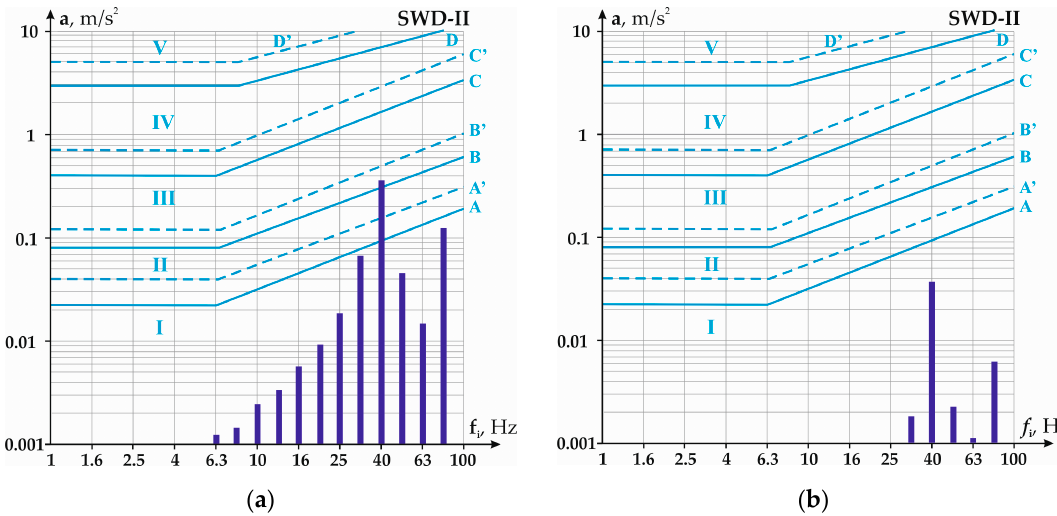
Figure 5. An example of the assessment of vibration impact according to SWD-II scale—in directions, respectively: ( a ) x and ( b ) y (stage III, mode X1, h = 0.4 m).